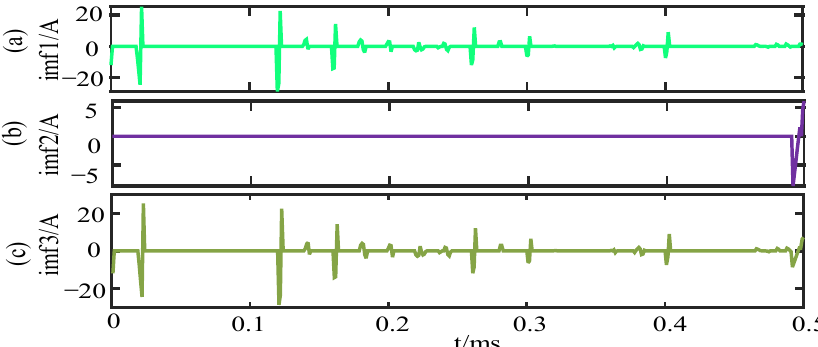
Figure 6. One Dimensional Fault Traveling Wave after Improved HHT.